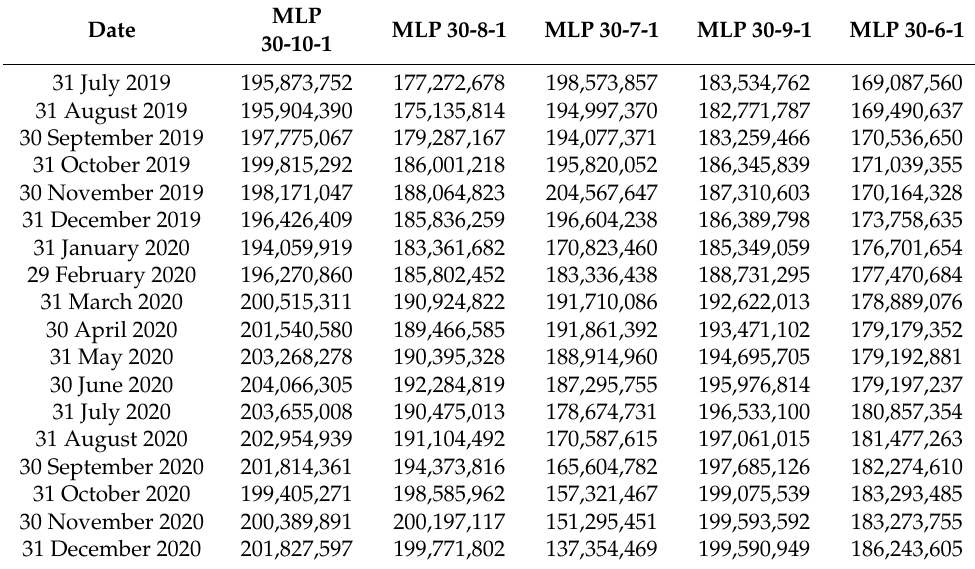
Table 7. Predicted exports from July 2019 to December 2020 according to the retained ANN (Experi- ment 3).